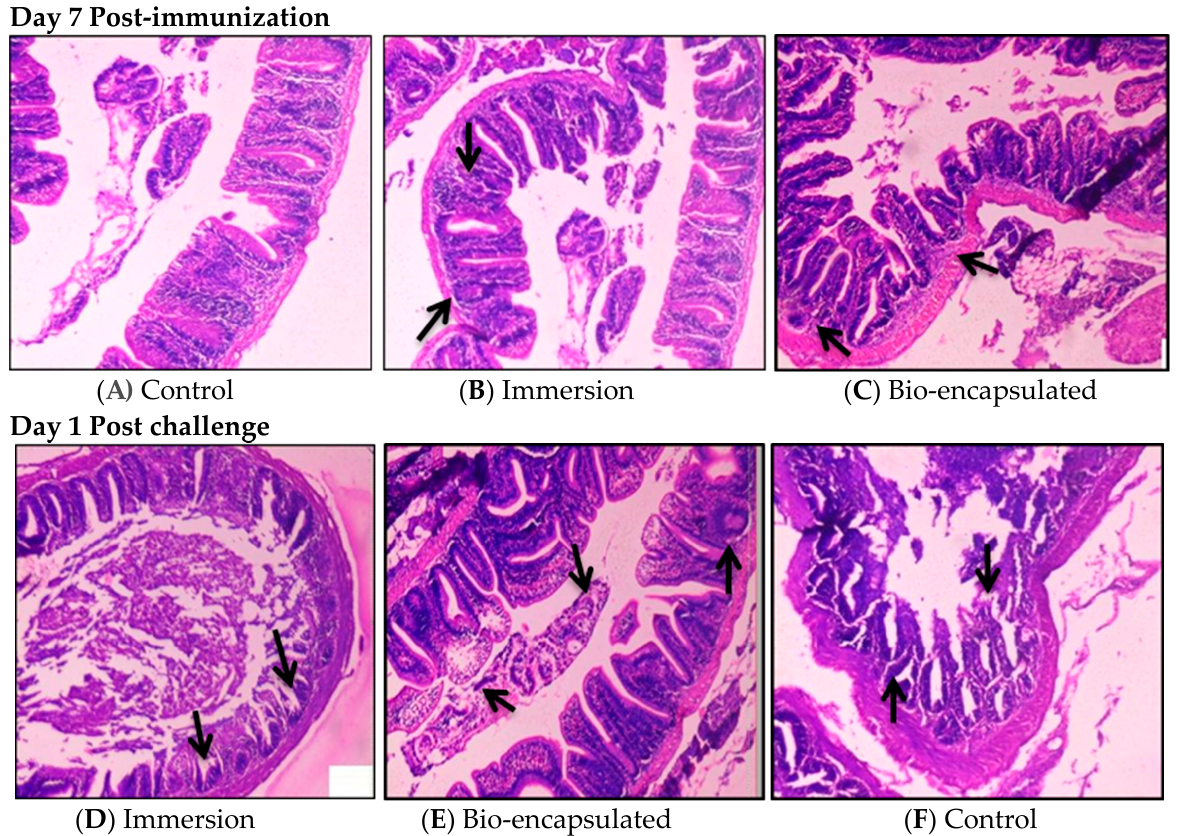
Figure 11. Histological studies of hindgut tissue in all groups of juvenile fishes (Control, Immersion and Bio-encapsulation) at 7 days post-immunization and 1 day post-challenge. ( B , C )-GALT tissue formation, lymphoid cell aggregation. No difference in control ( A ) at 7 d.p.v and at 1.d.p.c. ( D , E )—lymphoid cell aggregation, presence of macrophages. In the control group ( F ), necrosis and distortion in the microvilli structure was seen.